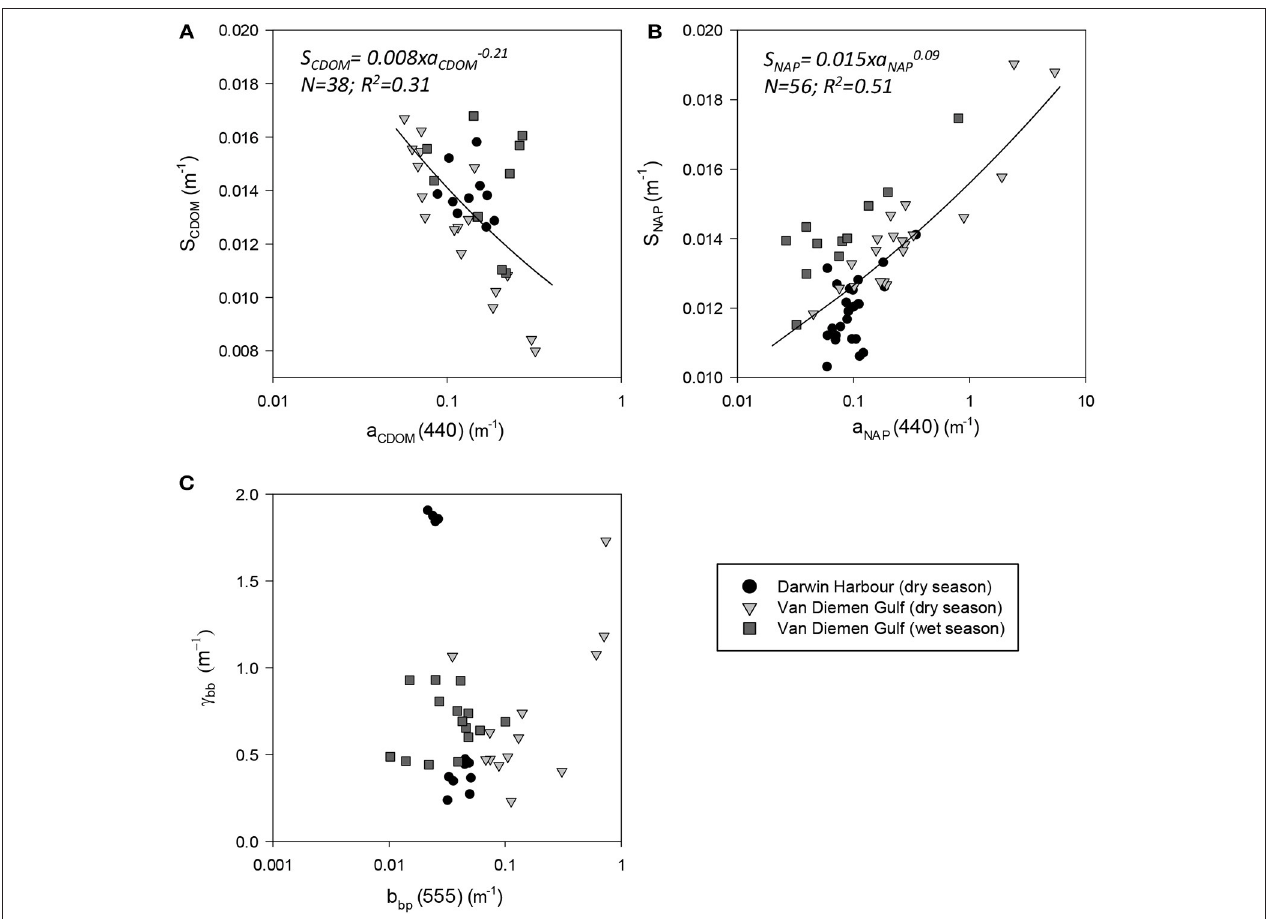
FIGURE 5 | Spectral slopes. Slopes of (A) CDOM, (B) NAP, and (C) b bp as a function of their respective coefficients.